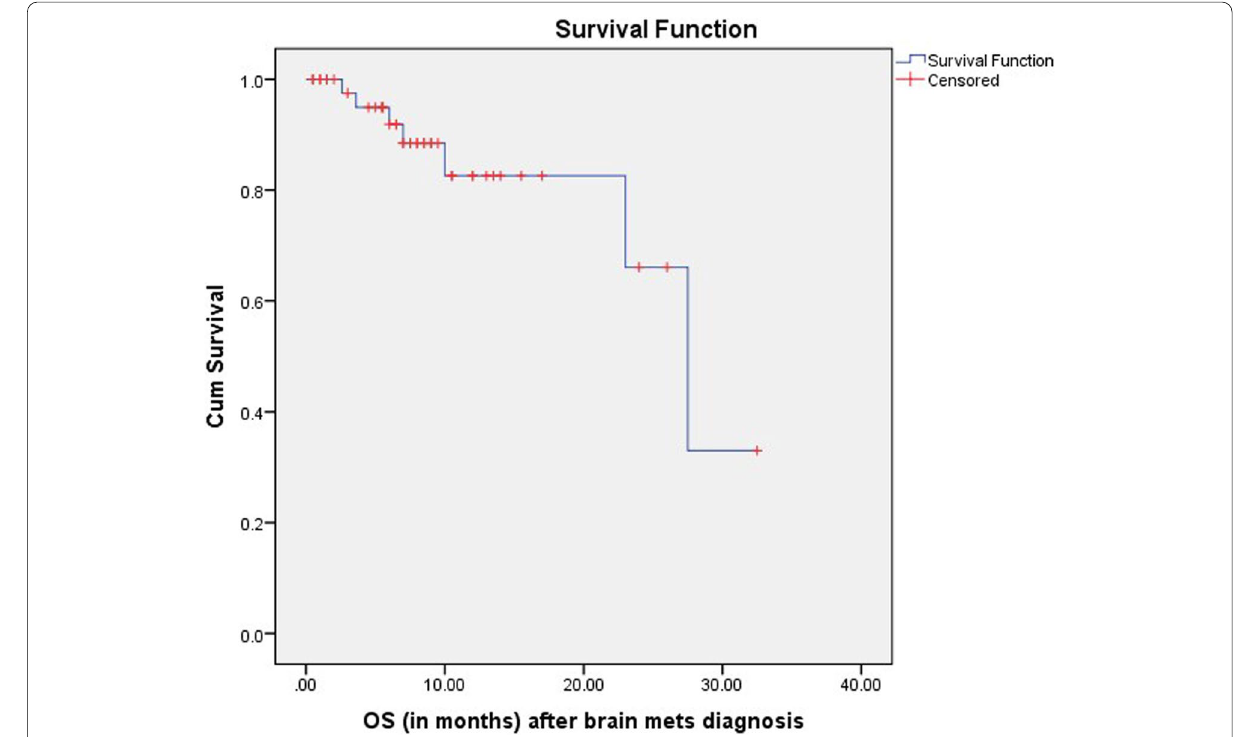
Fig. 1 Kaplan–Meier survival plot of BM